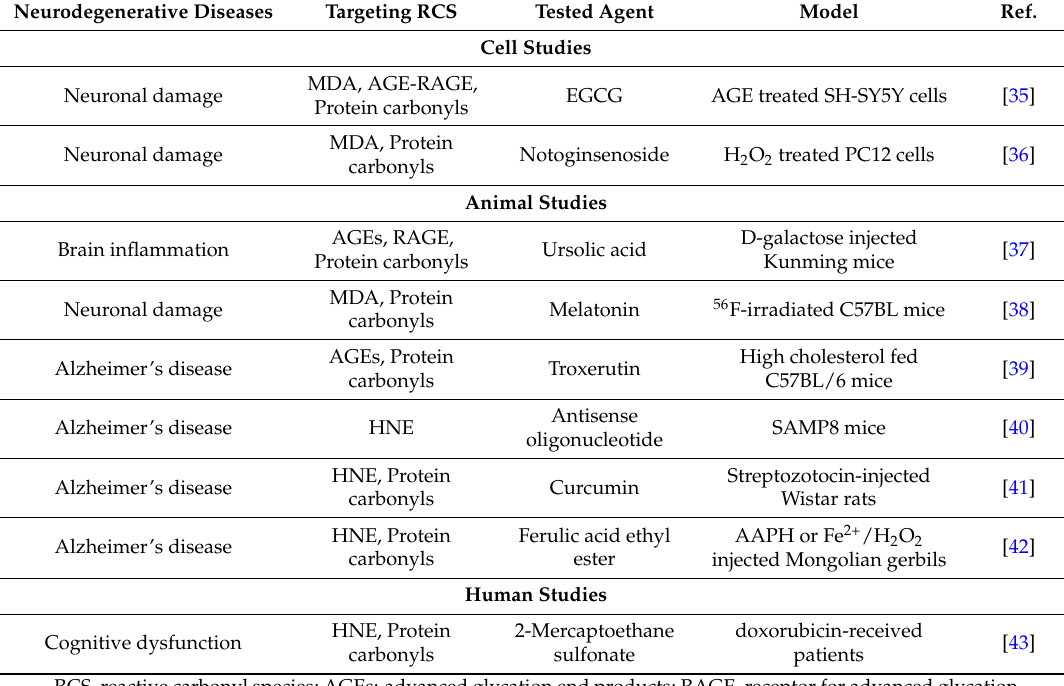
Table 2. Studies targeting reactive carbonyl species to prevent neurodegenerative diseases. Neurodegenerative